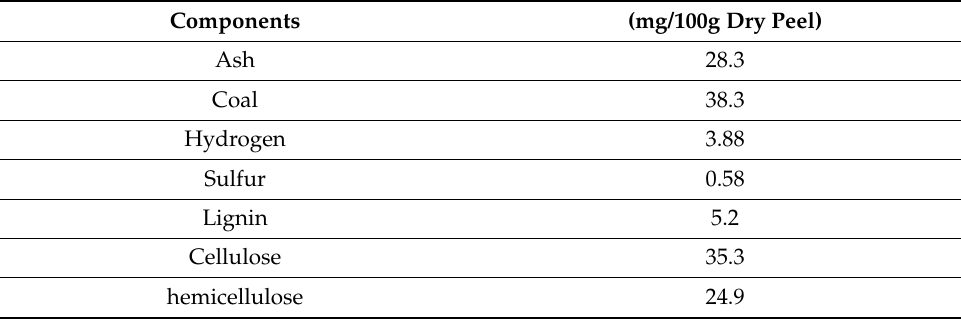
Table 4. Chemical composition of pseudostems from banana on a dry basis.